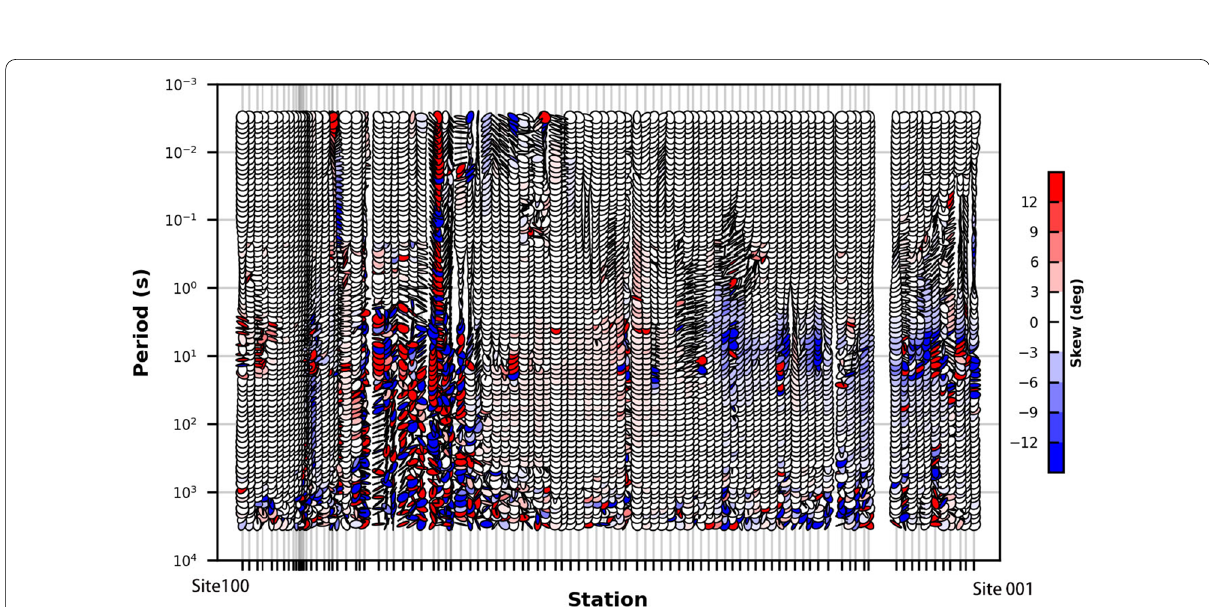
Fig. 4 Pseudo-section of phase